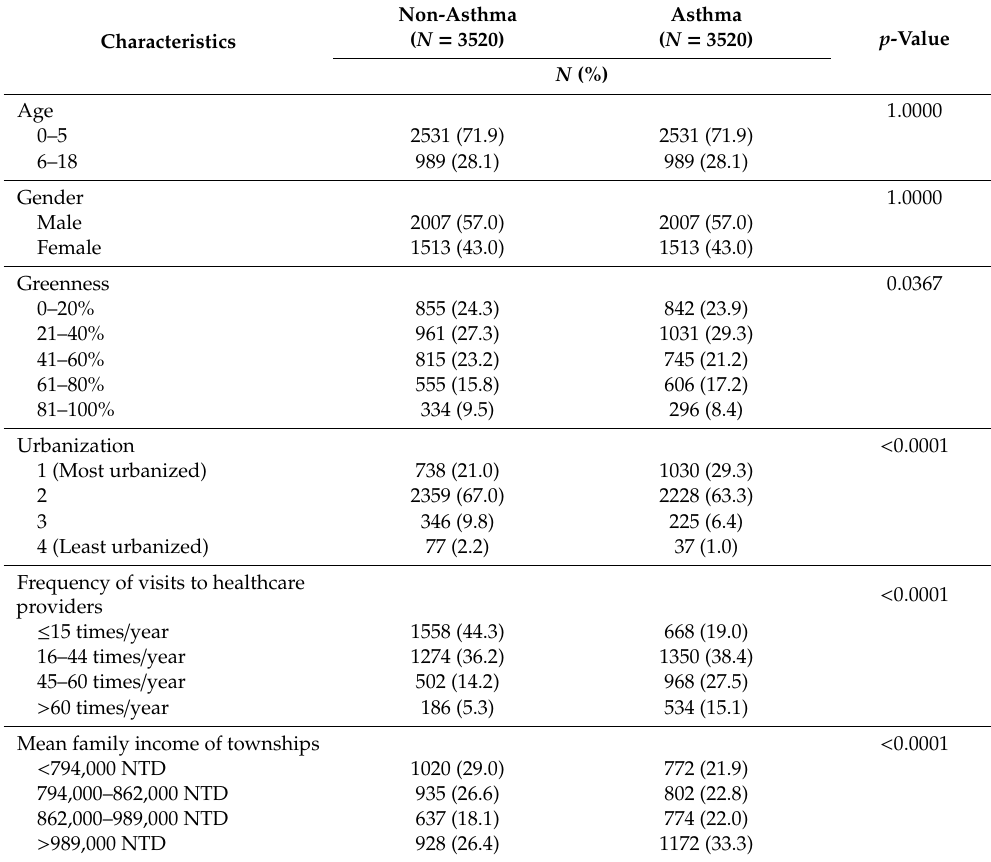
Table 1. Characteristics of the asthma cases and